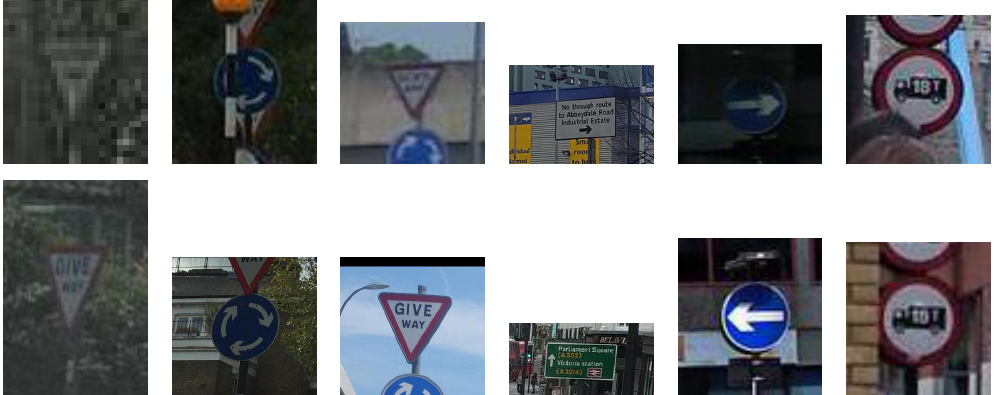
Figure 9. Pairs of Mapillary candidate matches ( top and bottom rows) that are correctly classified using our method ( Ours ) in comparison to the appearance-based only method ( w/o Geometry ). The first three columns show difficult situations correctly resolved as matches by Ours despite significant change in perspective, illumination, and background. Columns 4–6 (from left) show similar looking, neighboring signs correctly classified as not matching by Ours